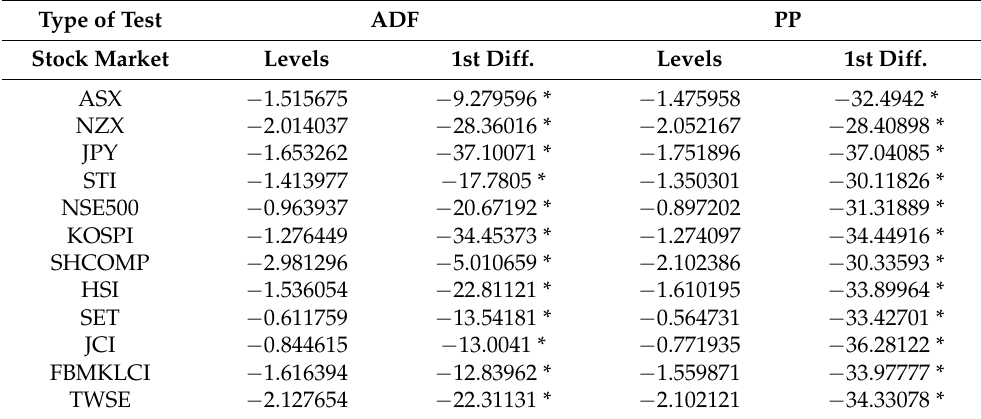
Table A3. ADF Unit Root Test of Stock Markets Data.